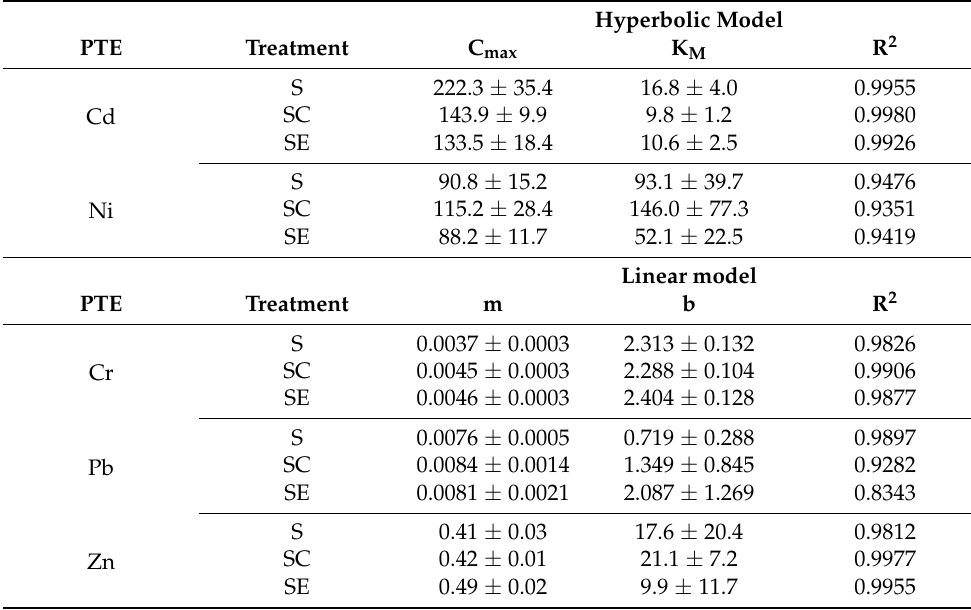
Table 3. Parameters of the models fitted to the PTE accumulation